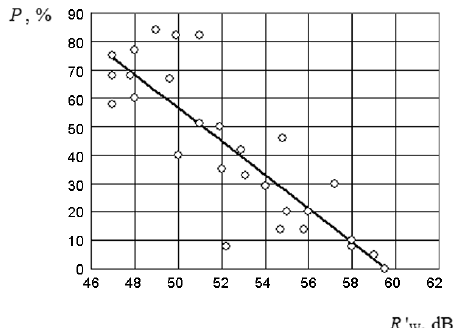
Fig. 6. Percentage of the occupants which evaluated their acoustic comfort level as poor depending on the horizontal partition’s (floor) weighted apparent sound reduction index R ’ w value (modified from Jagniatinskis 2003)